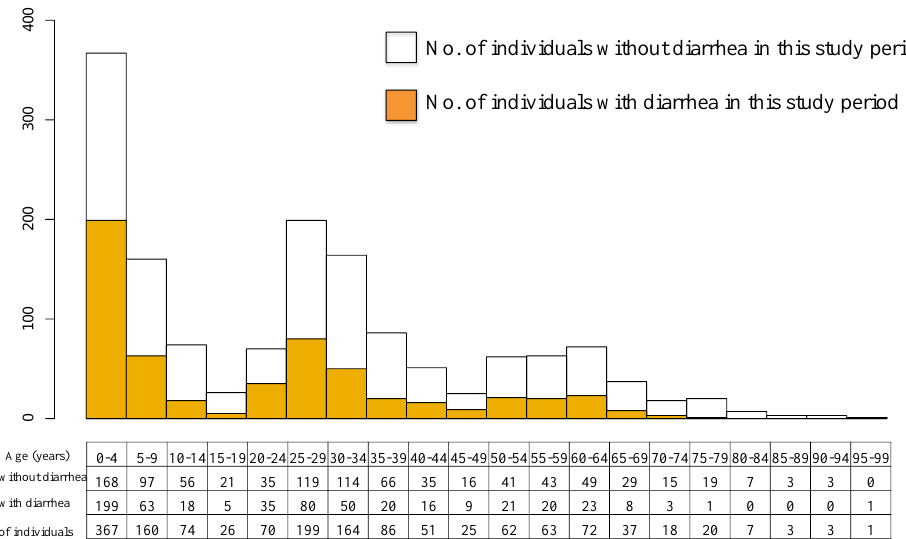
Figure 3. Age pyramid of the study population and diarrhea episode.